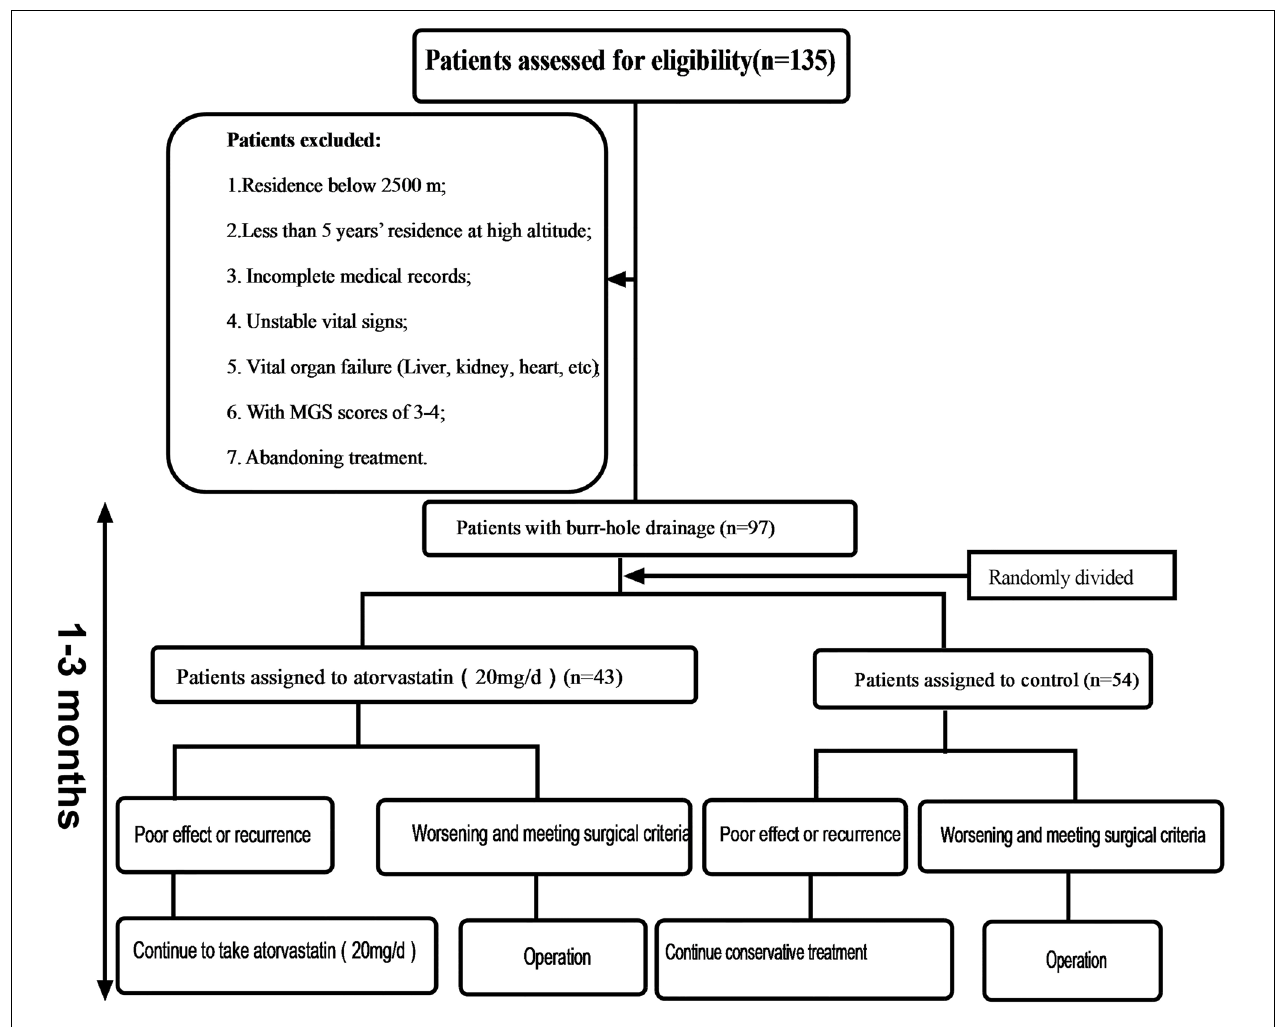
FIGURE 1 | A flowchart for the identification process of eligible